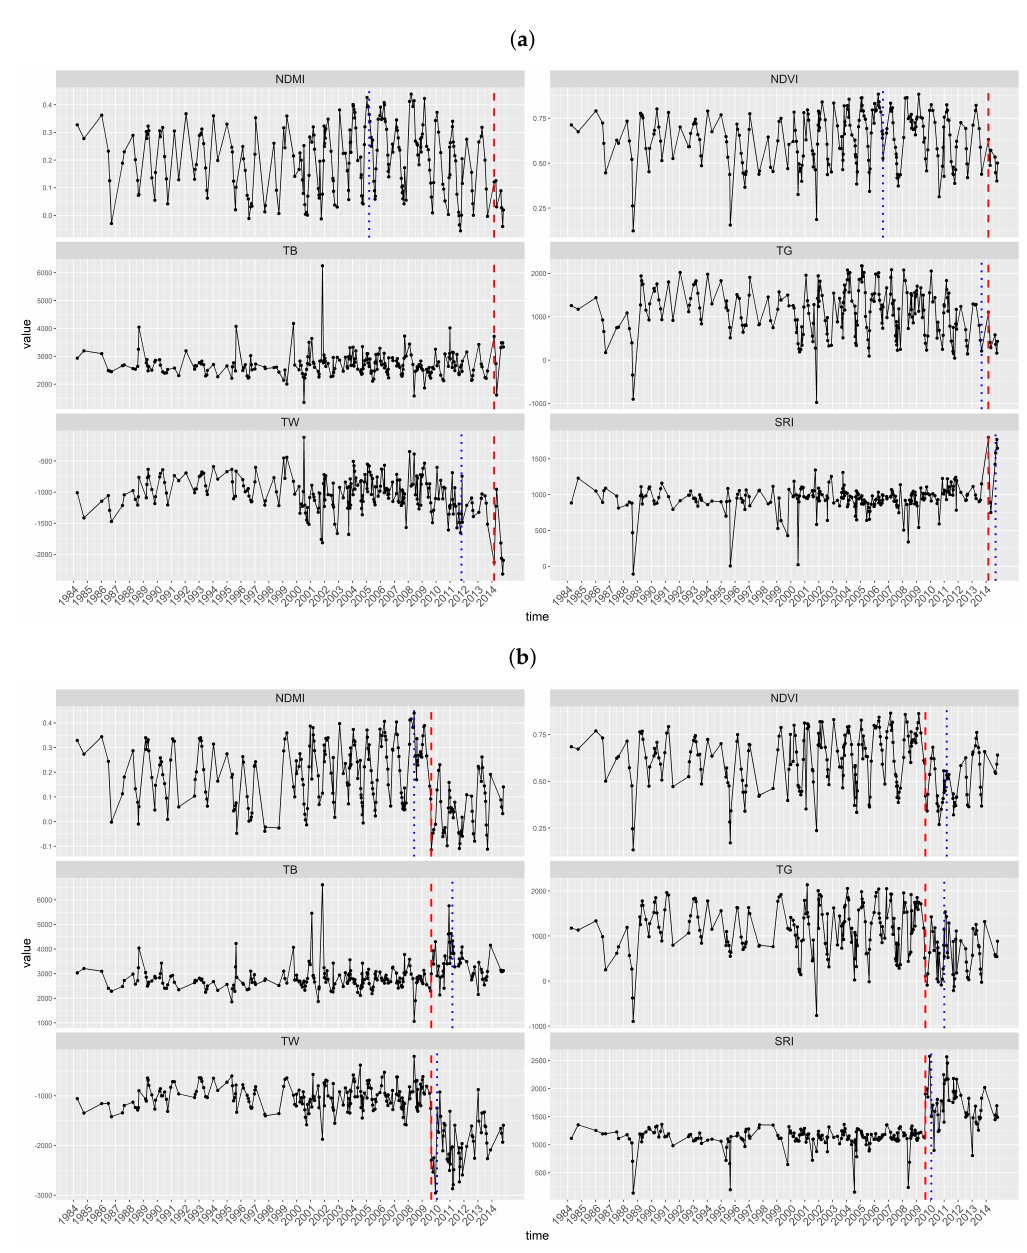
Figure 7. Time series of NDMI, NDVI, TCT and SRI at two sample locations of the Bolivian site. The red dashed line indicates real deforestation time; the blue dotted line indicates the time of MEFP detected deforestation. ( a ) Time series at location (18.341 ◦ S, 62.541 ◦ W); ( b ) time series at location (18.364 ◦ S, 62.584 ◦